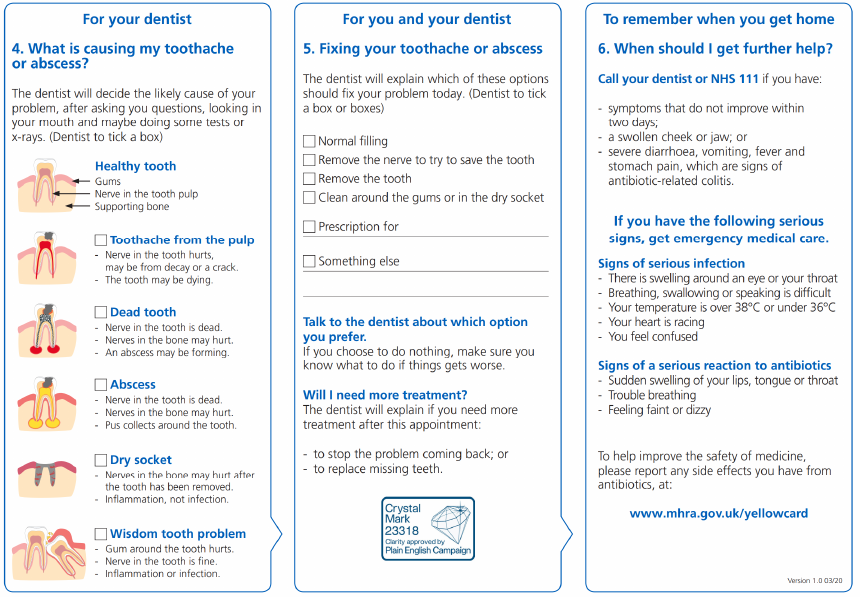
Figure 2. Side two of the shared decision-making worksheet coproduced to optimise dental antibiotic prescribing during urgent dental appointments. Reproduced with permission of University of